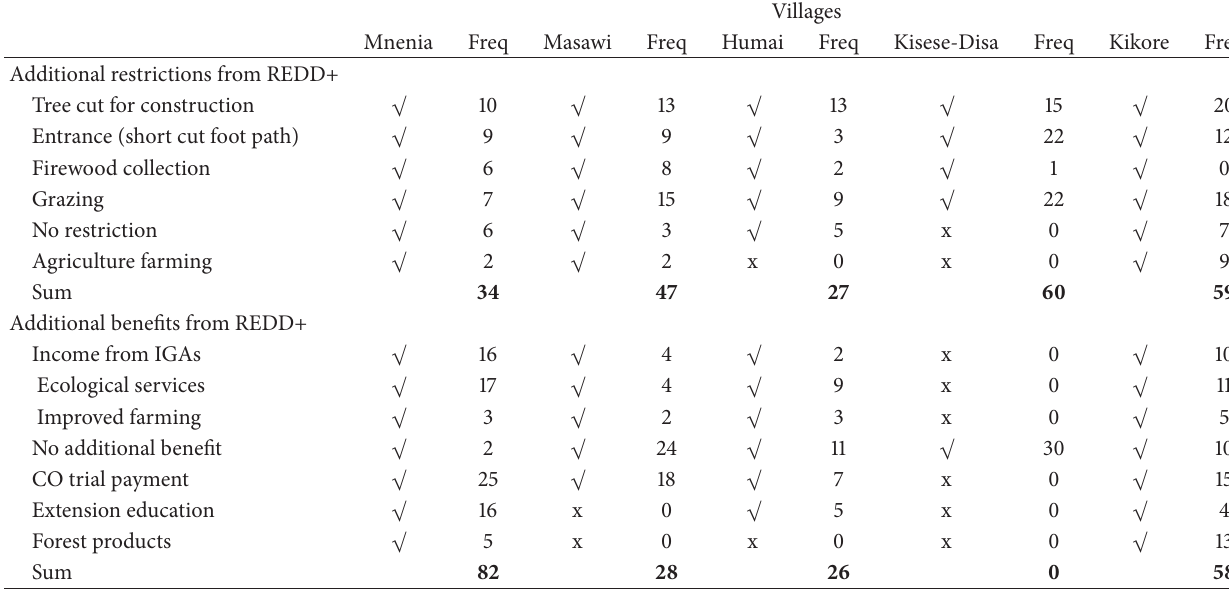
Table 1: Experienced additional restrictions and benefits on forests after REDD+ pilot project.